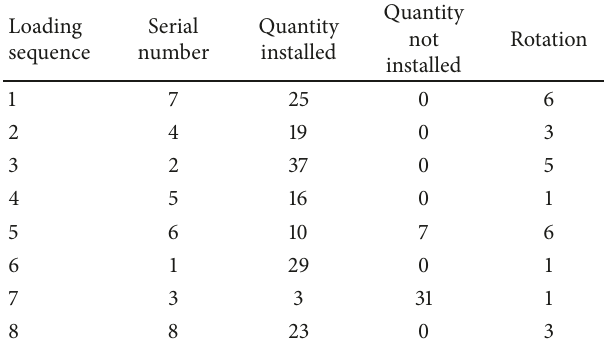
Table 3: Test result in LN02.